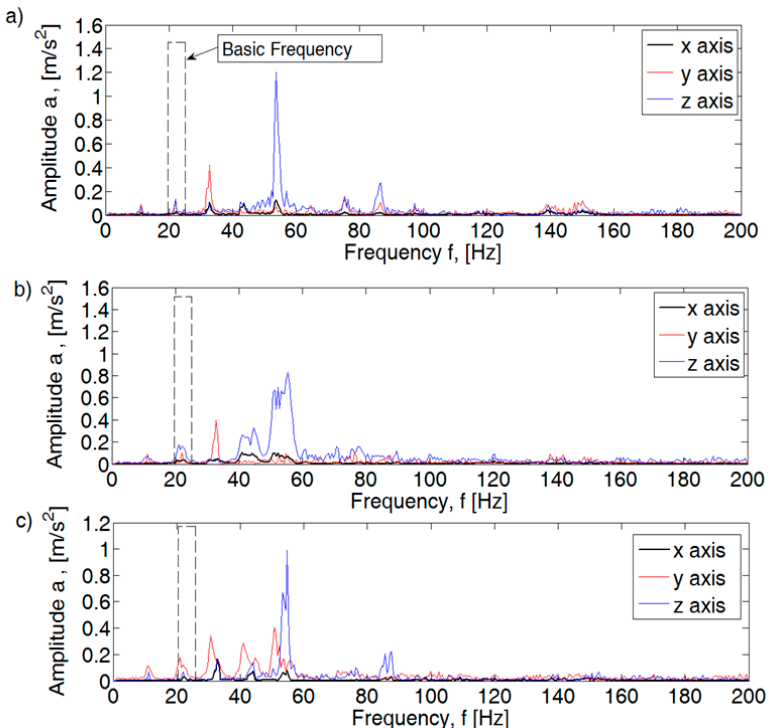
Figure 7. Fast Fourier Transformation FFT spectral amplitude for 1250 rpm combustion engine: ( a ) efficient, ( b ) injection inefficient, and ( c ) pressure inefficient.